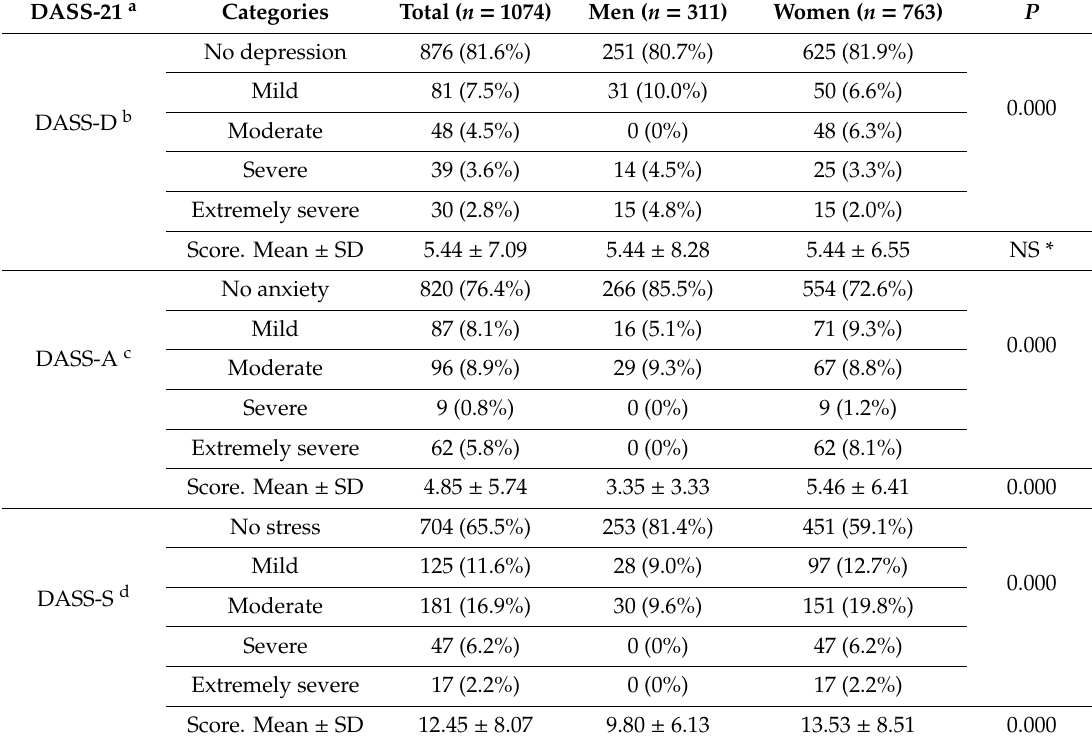
Table 2. Total scores from the DASS-21 and by